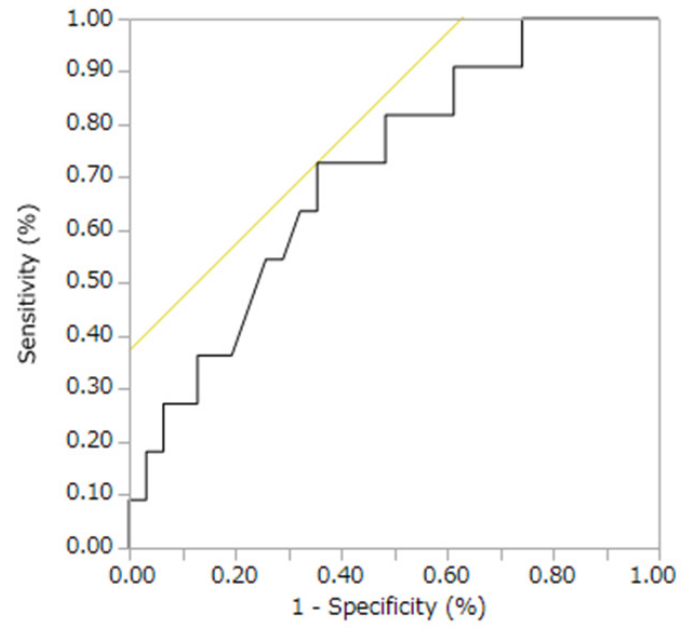
Figure 1. ROC curve of Hct.